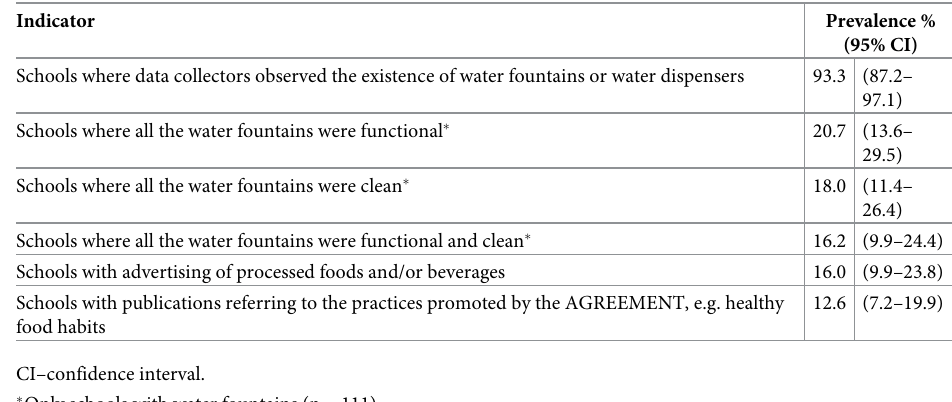
Table 4. Results of the evaluation of the physical environment (n =